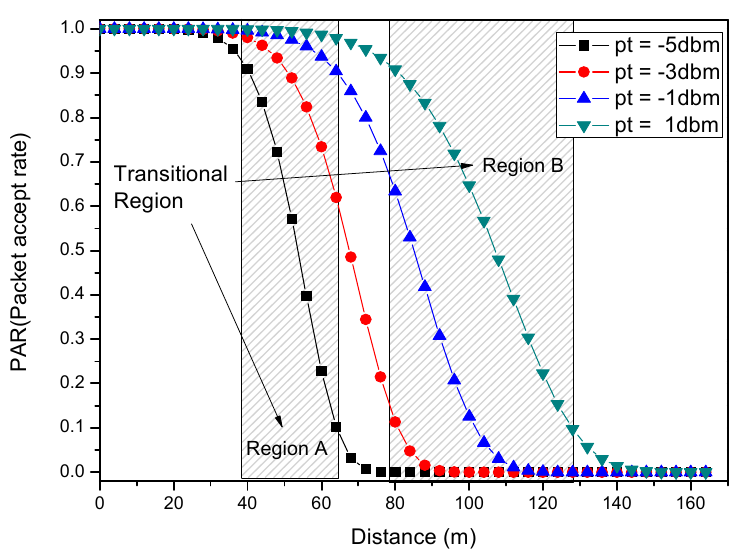
Figure 4. Packet acceptance rate and transmit power.